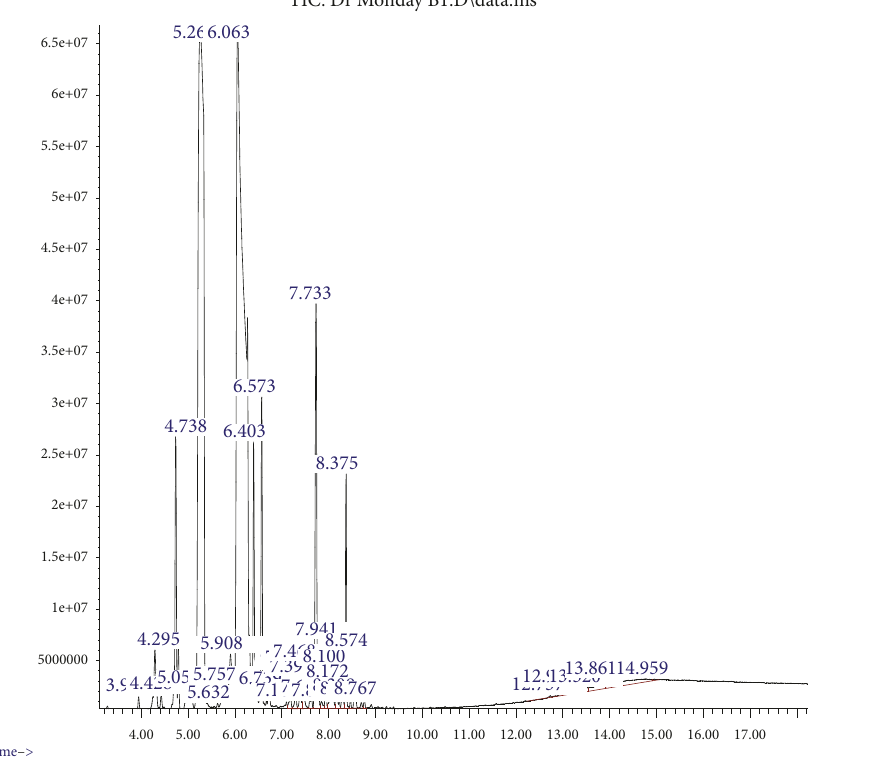
Figure 1: GC-MS chromatogram of sweet basil essential